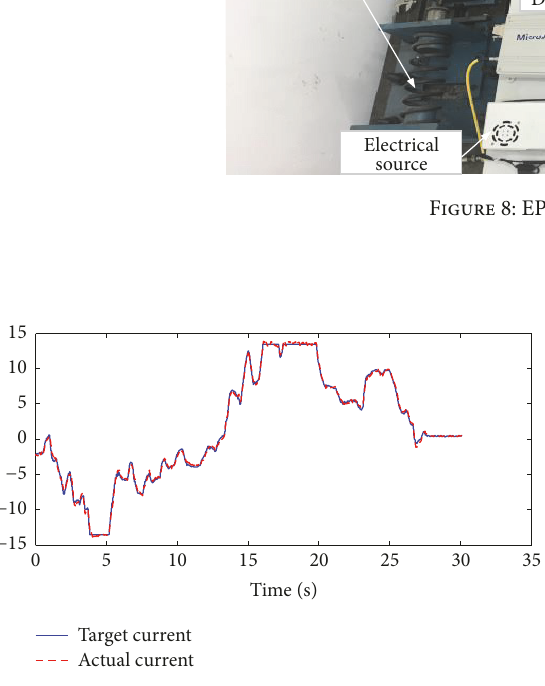
Figure 9: Hybrid sensitivity H ∞ control current tracking curve when in turn.